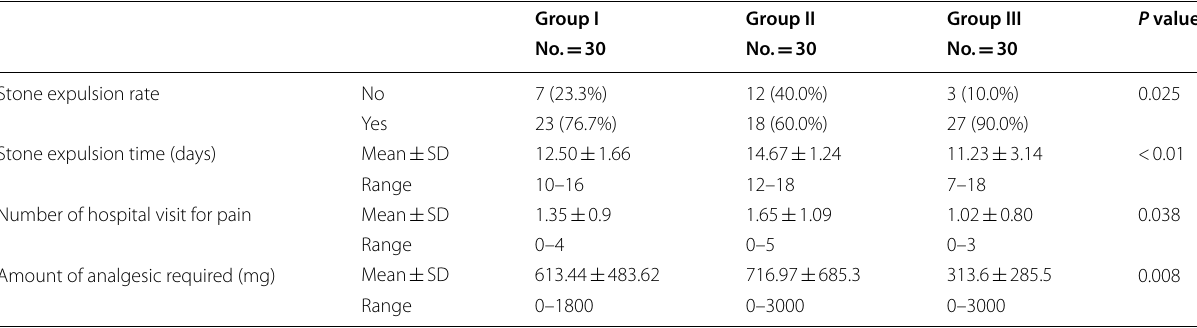
Table 2 Comparison between 3 groups regarding stone expulsion rate, stone expulsion time, number of hospital visits for pain and amount of analgesic required